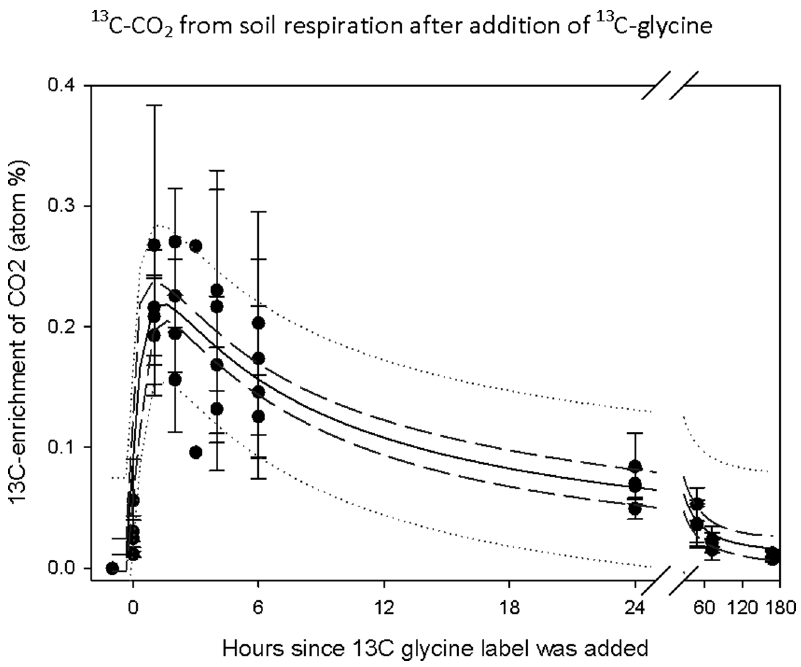
Figure 2. 13 C-CO 2 enrichment in soil air (atom %). A time-series beginning a few hours prior to addition of the 13 C-enriched glycine label till 168 hours after addition fit a log-normal curve: 13 C-CO 2 =1.108 + 1.359*exp( 2 0.5*(ln(T/3.269)/1.797) 2 )/T); (R 2 =0.8832). Curve indicates average, 95% Confidence Band and 95% Prediction Band.